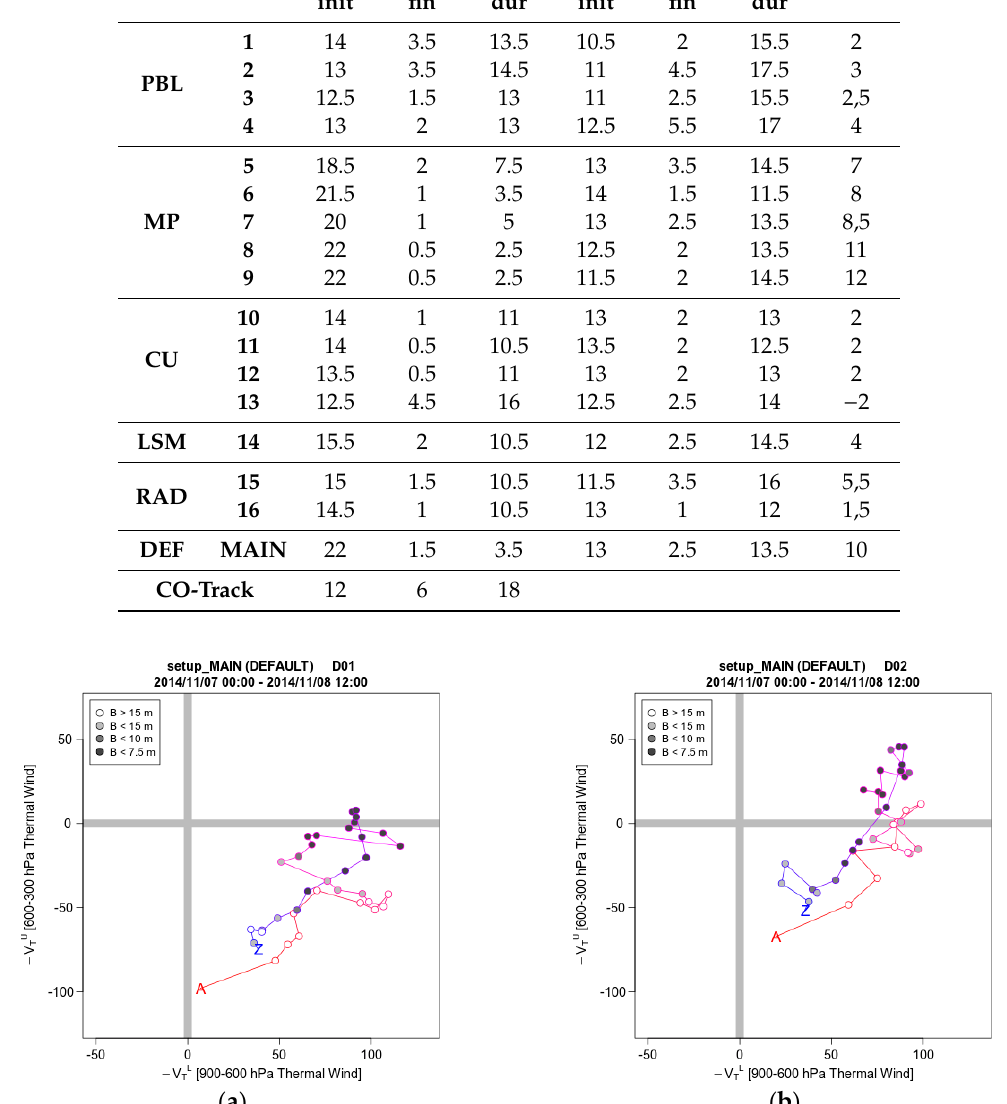
Figure 9. Phase space diagrams of − V TL (900–600 hPa) against − V TU (600–300 hPa) as predicted from control (setup-MAIN) experiment in ( a ) D01 and ( b ) D02 domain. Symmetry B is denoted by the shade of circles.